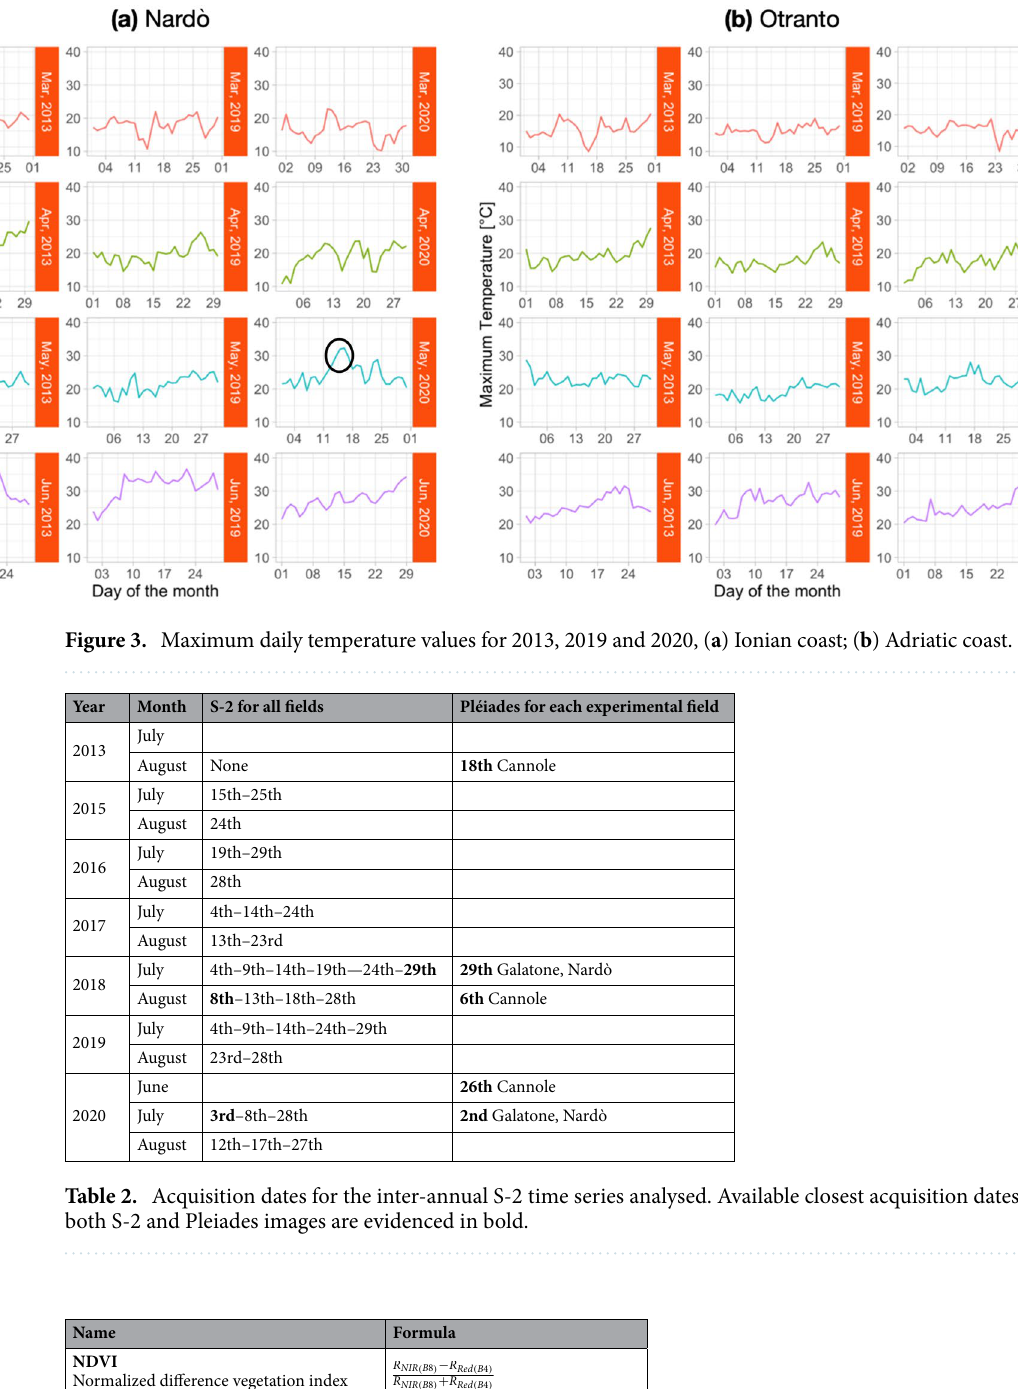
Name Formula NDVI Normalized difference vegetation